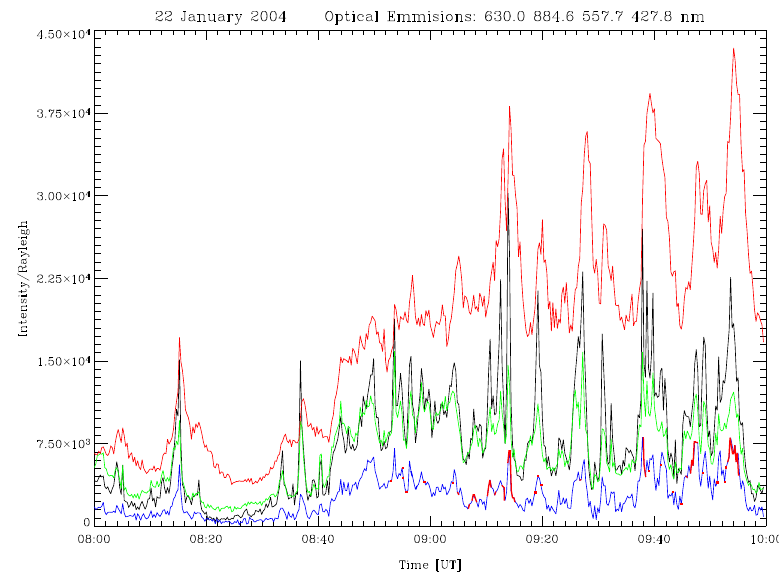
Fig. 4. Optical emissions corresponding to the field-aligned radar beam direction between 08:00–10:00 UT. The curves correspond to intensities of: 630.0nm (red), 844.6nm (black) × 4, 557.7nm (green) × 3 and 427.8nm (blue) × 2. NEIALs are marked with red at the 427.8nm curve. Note the delay of 630.0nm emission maxima due to the long lifetime.